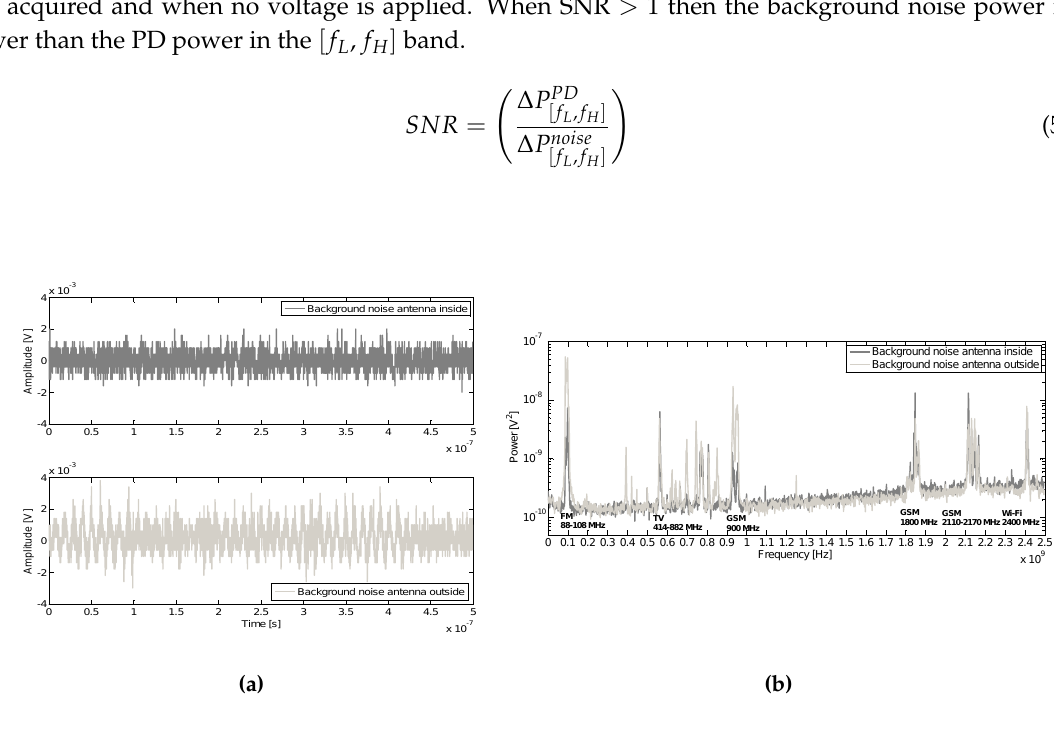
Figure 8. Background noise measured inside and outside the tank, ( a ) pulses and ( b ) spectrum with continuous sinusoidal noise from communications